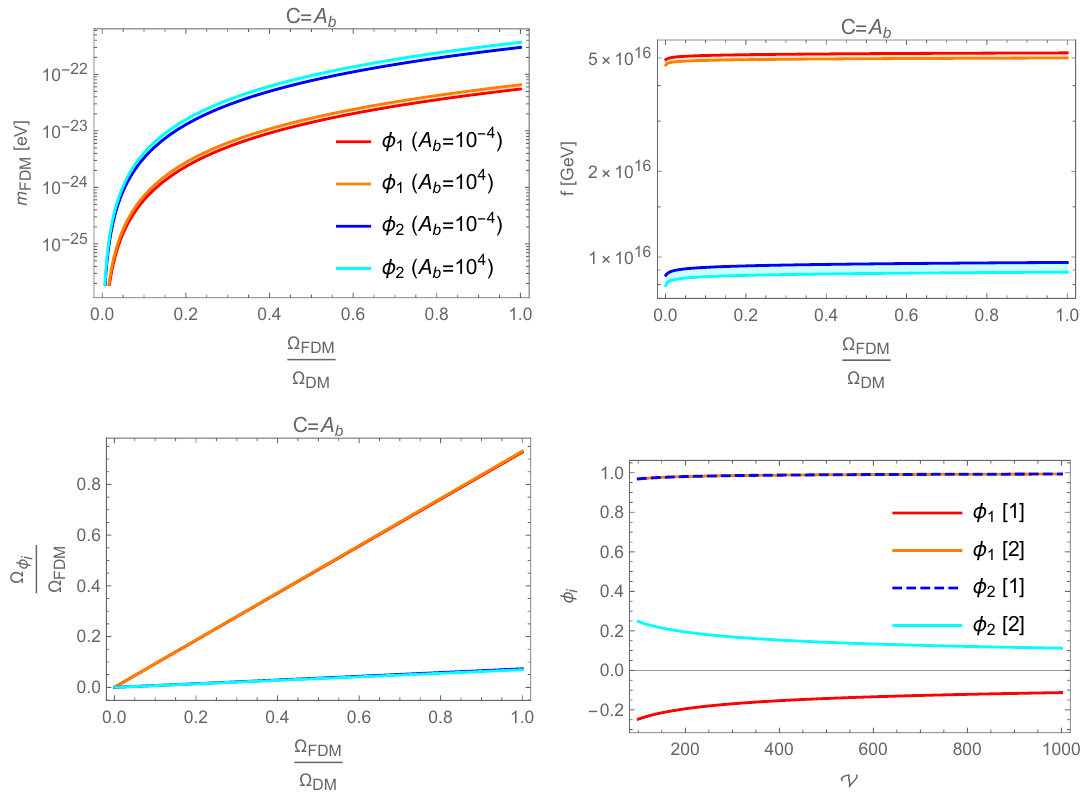
Figure 7 . Results about C 2 and C 4 axionic FDM from ED3/ED1-bound state instanton effects wrapping the overall volume cycle in the Swiss-cheese geometry. The results are given in terms of the mass matrix eigenvectors φ and φ , eq. (3.39). Top: axion masses (left) and decay constants 1 2 (right) as a function of the total ultralight axionic dark matter fraction. Bottom-left: relative abundance of the axionic DM particles. Bottom-right: eigenvectors components as a function of the overall volume V . We see that also at small volumes the eigenvectors of the mass matrix φ and φ are mainly given by the C and C axion 2 2 4